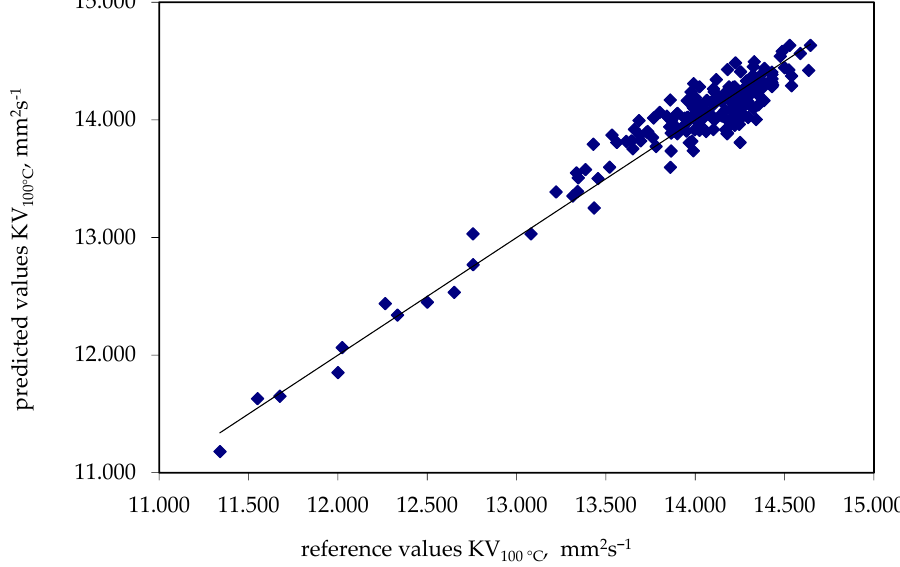
Figure 2. Regression dependence between kinematic viscosity values at 100 °C predicted by FTIR-PLS model and determined by the standardized method; the regression line equation is y = 0.8774x + 1.7230, R = 0.95